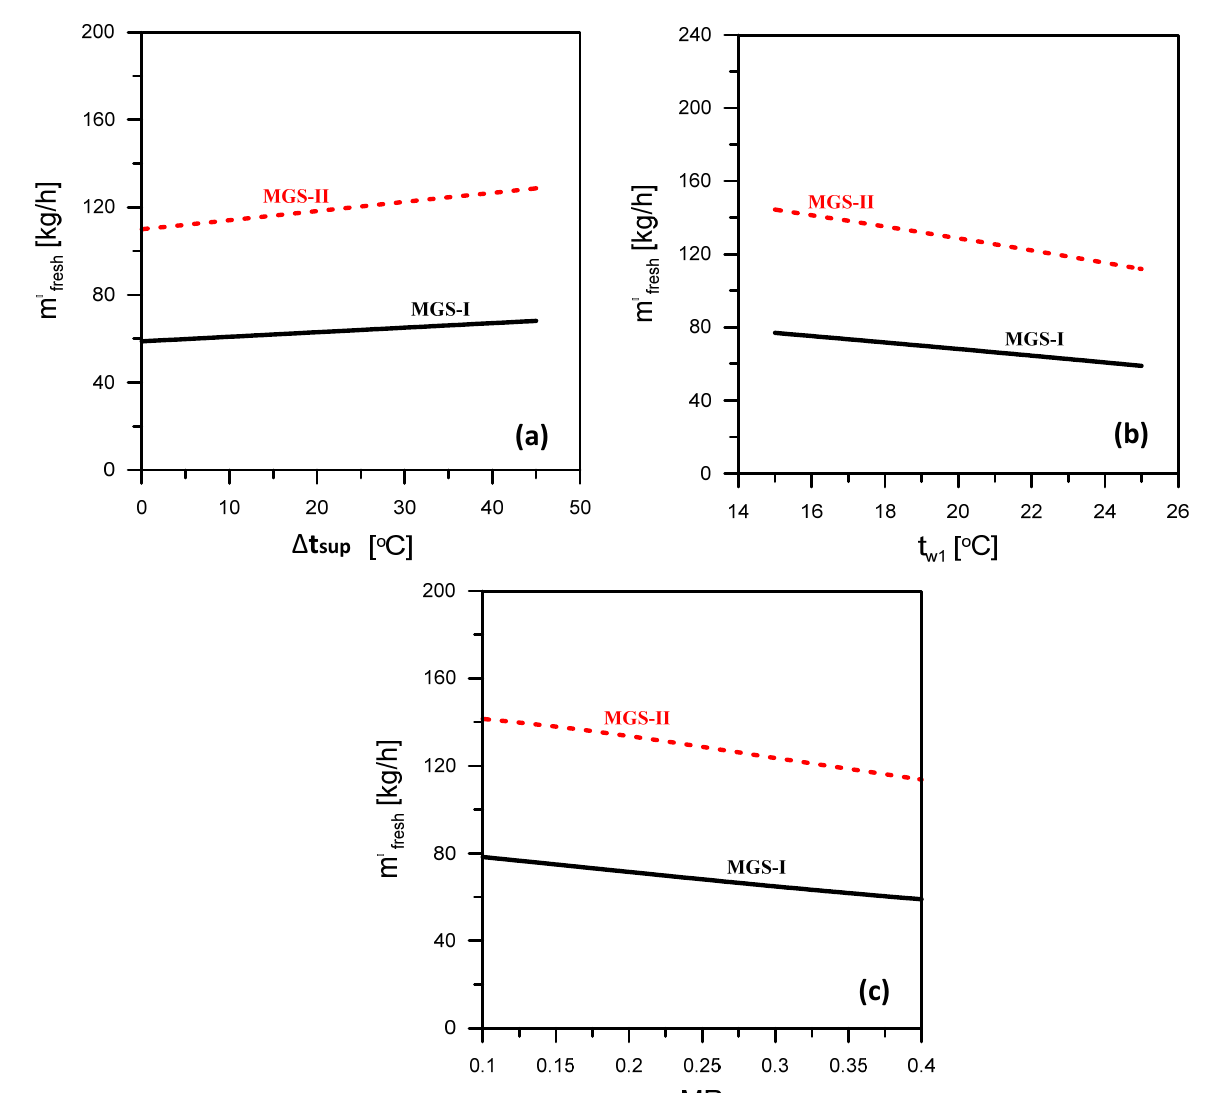
Figure 3. Impact of studied parameters on freshwater: ( a ) Δ t sup ; ( b ) t w1 ( c ) 𝑚(cid:4662) (cid:3033)(cid:3045)(cid:3032)(cid:3046)(cid:3035) . Table 4. Power, ORC thermal efficiency, and area of solar collectors for MGS-I and MGS-II.